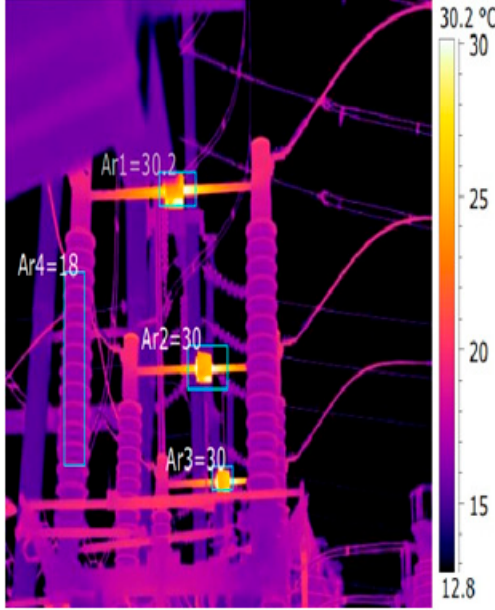
Figure 2. Sample thermal image with possible expected defects.